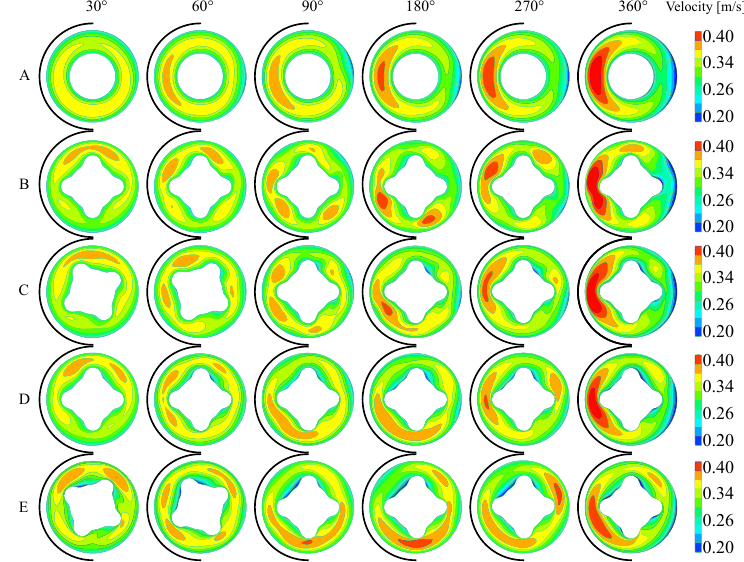
Figure 9. Velocity contours for the outer tube with Dean number 1000 for inner tube and with Dean number 4411 for outer tube. A: tube-in-tube. B: four ridges without twist. C: four ridges with 1 twist. D: four ridges with 3 twist. E: four ridges with 5